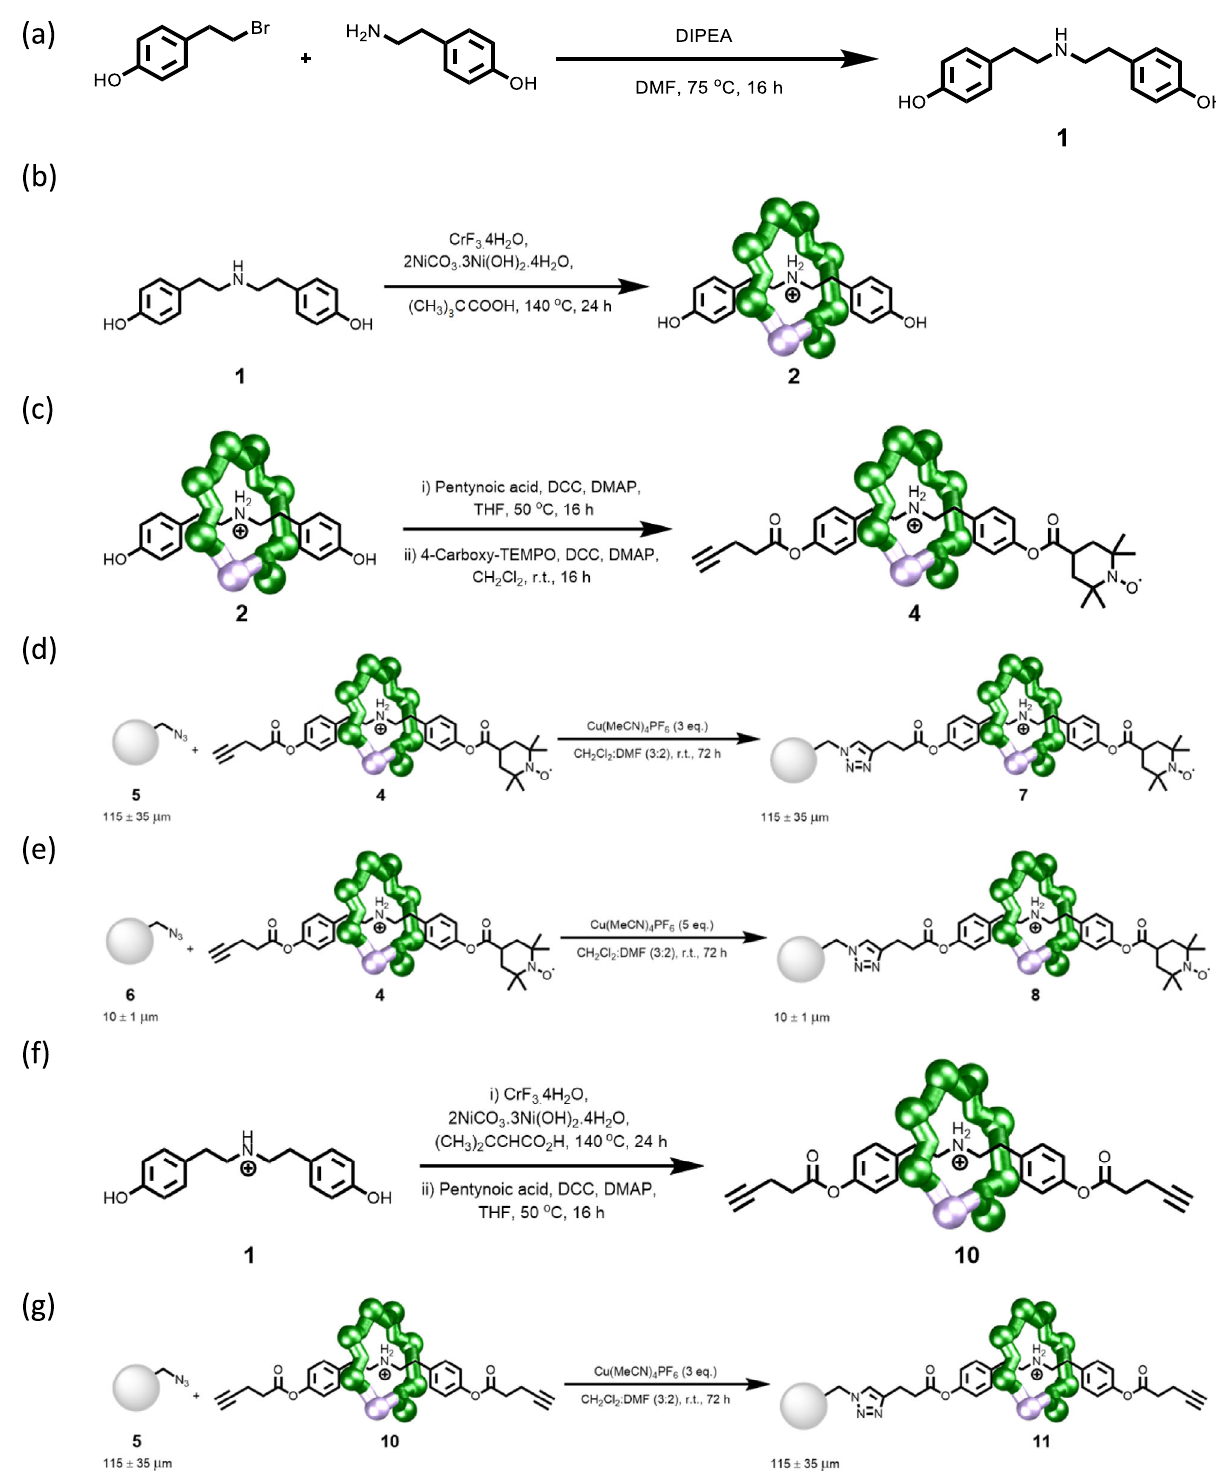
Fig. 6 Synthetic reactions. a Synthesis of thread 1 . b Synthesis of 2 . c Synthesis of 4 . d Synthesis of 7 . e Synthesis of 8 . f Synthesis of 10 . g Synthesis of 11